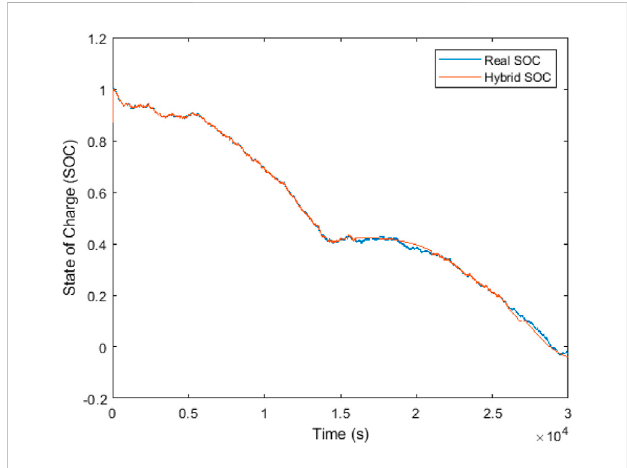
FIGURE 13 Hybrid estimator performance under INR